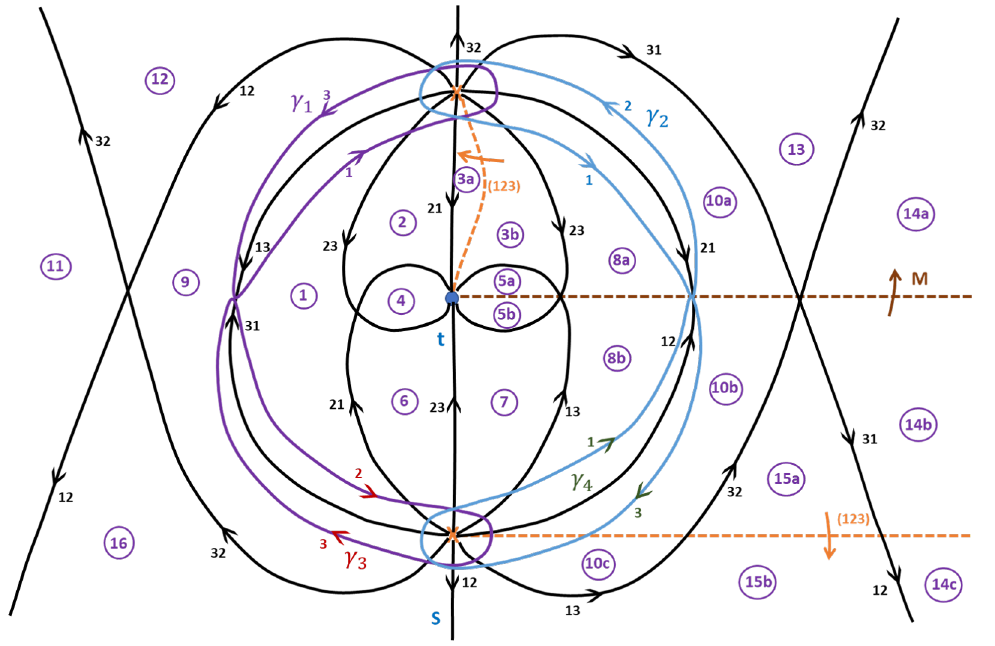
Figure 4 . The Stokes graph at θ = π/ 3 with u 1 = u 2 = 0 and Λ = 1 . The irregular singularity at z = 0 is represented by a blue dot, while the irregular singularity at z = ∞ is not shown in the figure. Branch points and branch cuts are denoted by orange crosses and orange dashed lines respectively. The monodromy cut is represented by a brown dotted line. We also show representative cycles corresponding to the basis charges γ The Stokes graph divides the puntured-plane into 16 regions, which are labeled by circled purple